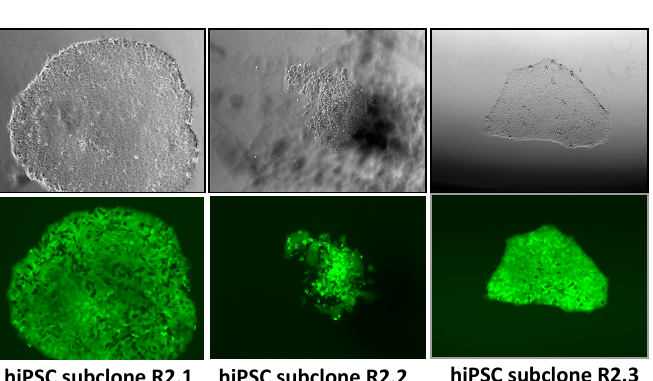
Figure 3. Evaluation of GFP expression stability in primary alphoid tetO -HAC-GFP human pluripotent stem cells (hiPSC) colonies. ( a ) Following the retro-MMCT procedure, GFP-positive colonies became visible on day 5–7; they were picked up and expanded as R1 and R2 alphoid tetO -HAC-GFP hiPSC clones. ( b ) The mixed clone R2 was further sub-cloned, giving rise to the homogeneous GFP-positive subclones R2.1, R2.2, and R2.3.